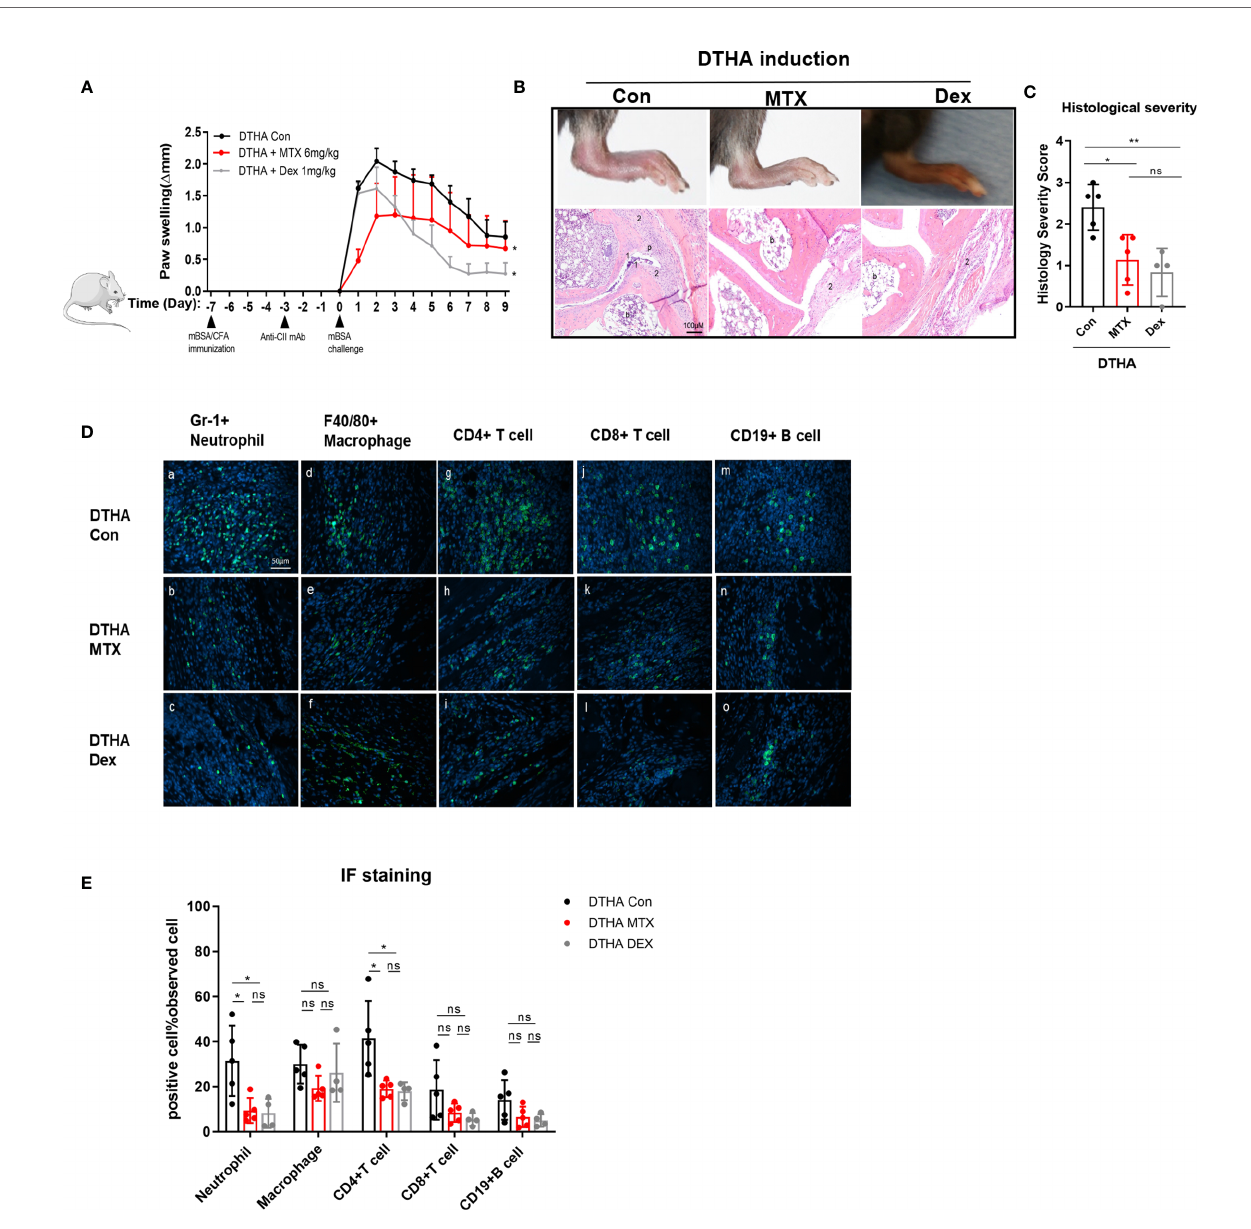
FIGURE 7 | Differential effects of MTX and DEX on DTHA-induced paw swelling but not in fl ammation. (A) Dynamic effects of MTX (6 mg/kg) and DEX (1 mg/kg) on paw swelling from day 0 to day 9 after the mBSA challenge. Changes of paw swelling ( D mm) were used to determine effects of MTX and DEX. (*) signi fi cant difference in paw swelling between DTHA mice treated with or without MTX or DEX. Data are representative of two independent experiments (n = 4 – 6 mice in each group). (B) Representative H&E-stained sections (3.5 µM) of the paws were analyzed from one experiment from DTHA mice treated without (n = 5 mice) or with MTX (n = 5 mice) or DEX (n = 4 mice) on day 9. Original magni fi cation is ×200; scale bar, 100 m m; b: bone marrow; p: pannus; 1: destruction of joint cartilage; 2: in fl ammation in fi ltration. (C) Histology scores were calculated by the evaluation scale (see Materials and Methods ). (D) Representative images of immuno fl uorescence staining on day 9 for neutrophils (Gr-1+) (a – c), macrophages (F4/80+) (d – f), CD4+ T cells (CD4+) (g – i), CD8+ T cells (CD8+) (j – l), B cells (CD19+) (m – o) of paws from one experiment from DTHA mice treated without (n = 5 mice) or with MTX (n = 5 mice) or DEX (n = 4 mice). Original magni fi cation, ×400; scale bar, 50 m m. Hoechst 33342 (blue color) was used for nuclear counterstaining, while corresponding surface marker was shown in green color. (E) Quanti fi cation of Gr-1+ neutrophils, F4/80+ macrophages, CD4+ T cells, CD8+ T cells, and CD19+ B cells. Values are expressed as the mean ± SD. Statistical signi fi cance in panel A was calculated by Student ’ s t -test (*p < 0.05) to compare the difference between DTHA control mice and DTHA mice treated with MTX or DEX. Statistical signi fi cance in panels C and E was calculated by ANOVA with Tukey multiple comparison test (*p < 0.05, **p < 0.01, ns: p > 0.05). Con, DTHA Control group. The mouse image is from